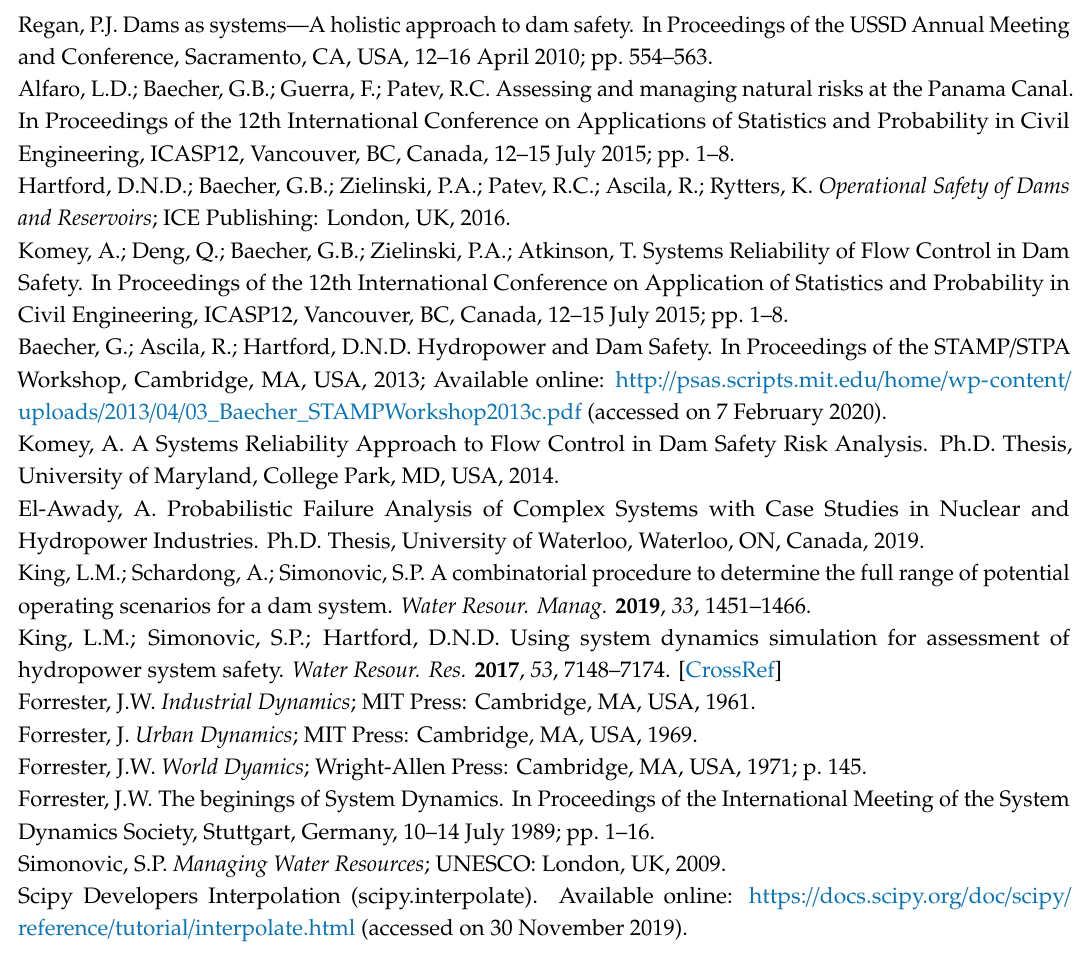
Table S1: Criticality parameters for all 552,960 scenarios “S1.xlsx”, Table S2: Gate rating curve for the case study example “S2.xlsx”, Table S3: Case study scenario results spreadsheet for all 10,000 iterations “S3.xlsx”, File S1: Additional information pertaining to the case study “S1.pdf”, and File S2: Scenario results arrays which can be read in python